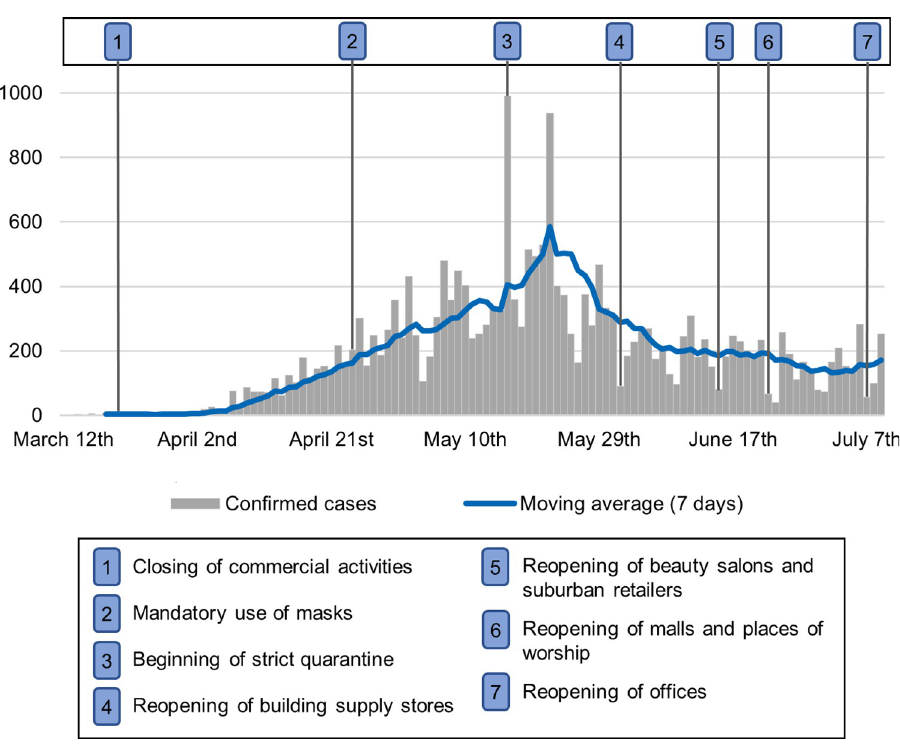
Fig 3. Evolution of daily COVID-19 cases in Recife from March 12 th to July 8 th , 2020.